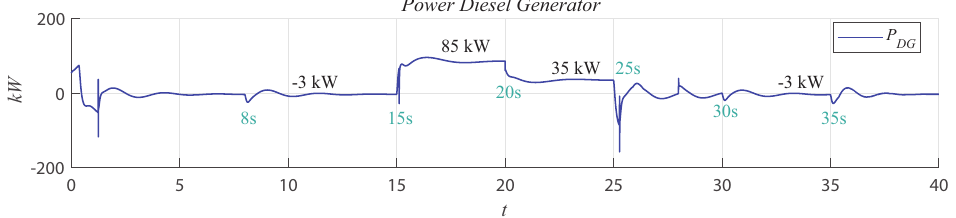
Figure 19. Power in the DG for case study